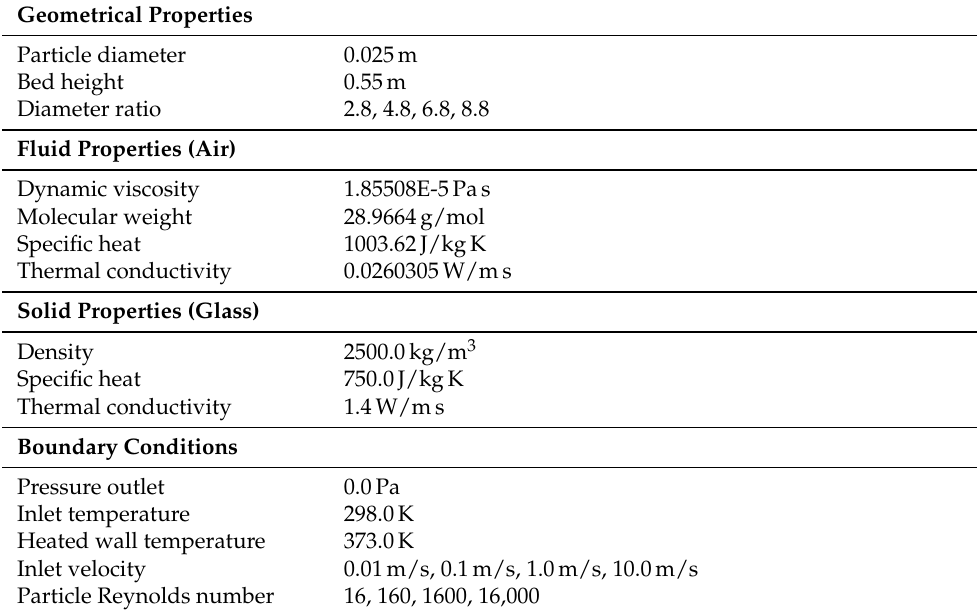
Table 3. Parameters and boundary conditions used for the computational fluid dynamics (CFD)